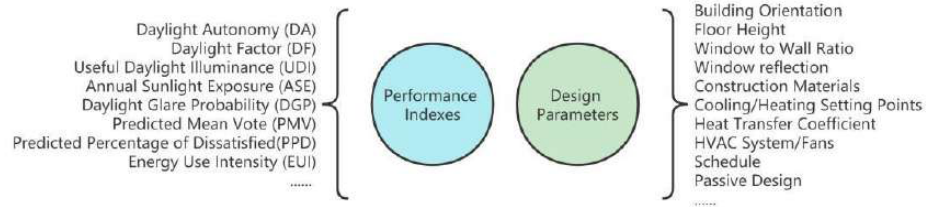
Figure 6. Correspondence between building performance indicators and design parameters.